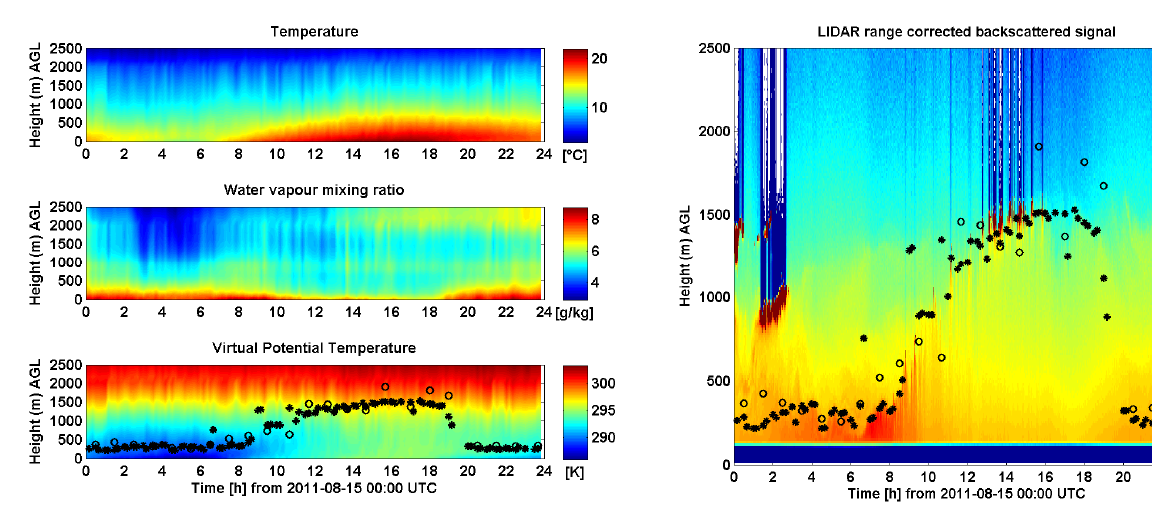
Fig. 2. 24h time–height cross section of range corrected backscat- Figure 2: 24-hour time–height cross section of range corrected backscattered signal as 2 tered signal as measured by the ALS450 lidar at SIRTA on 15 Au- measured by the ALS450 lidar at SIRTA on August 15, 2011. Black stars and circles indicate 3 gust 2011. Black stars and circles indicate the MLH estimates from the MLH estimates from lidar and MWR data, respectively, as discussed in Section 3. 4 lidar and MWR data, respectively, as discussed in Sect.